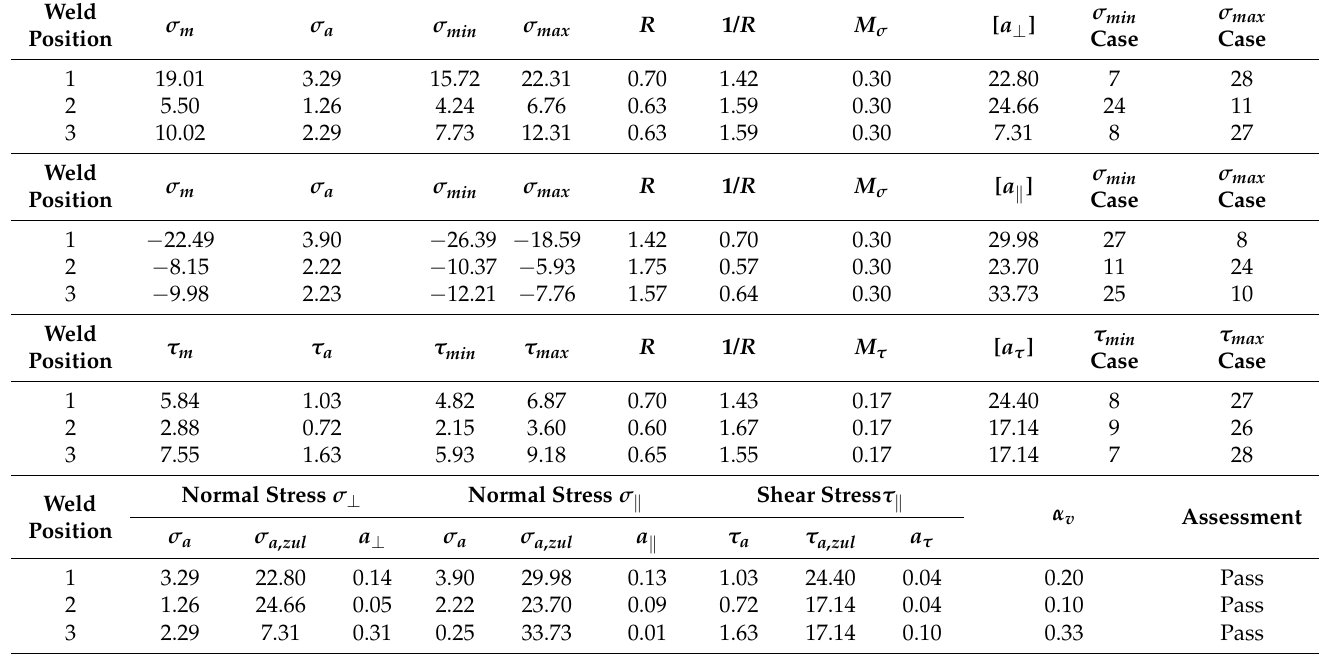
Table 3. Fatigue evaluation assessment